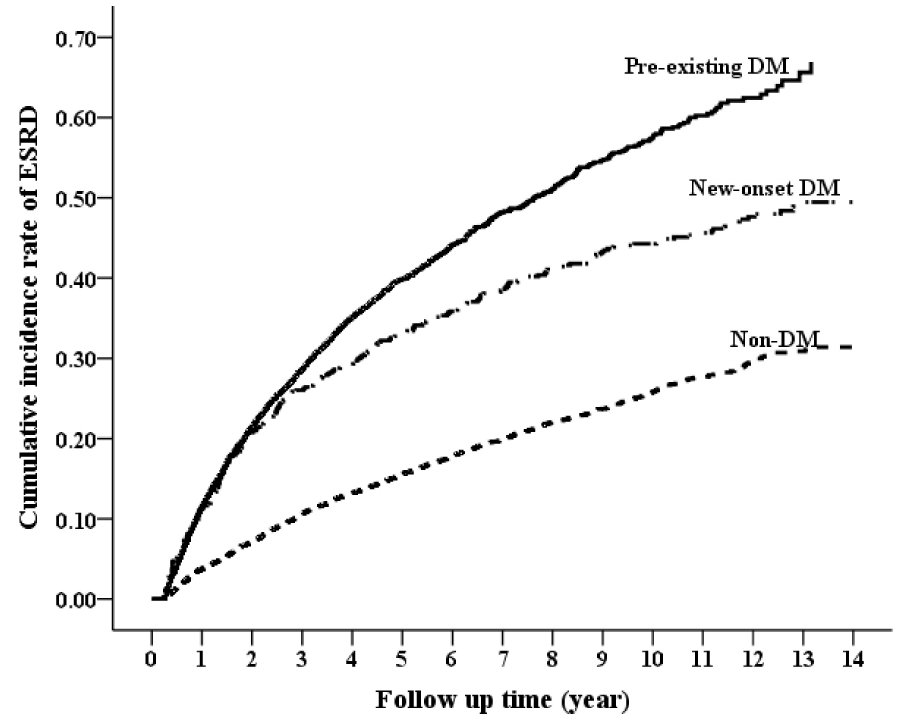
Figure 2. Cumulative incidence rate of progression to end-stage renal disease between pre-existing DM, non-DM, and incident DM